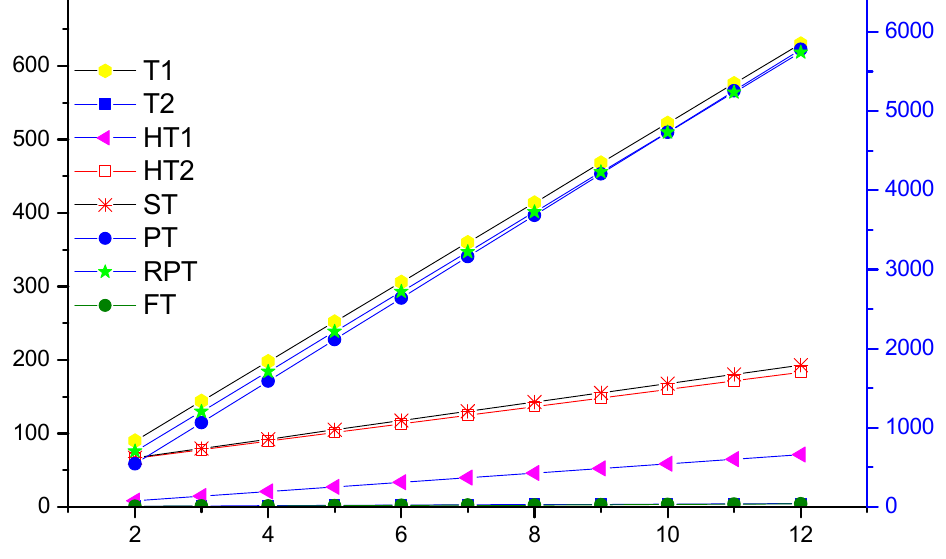
Figure 3. 2D graphical comparison of temperature